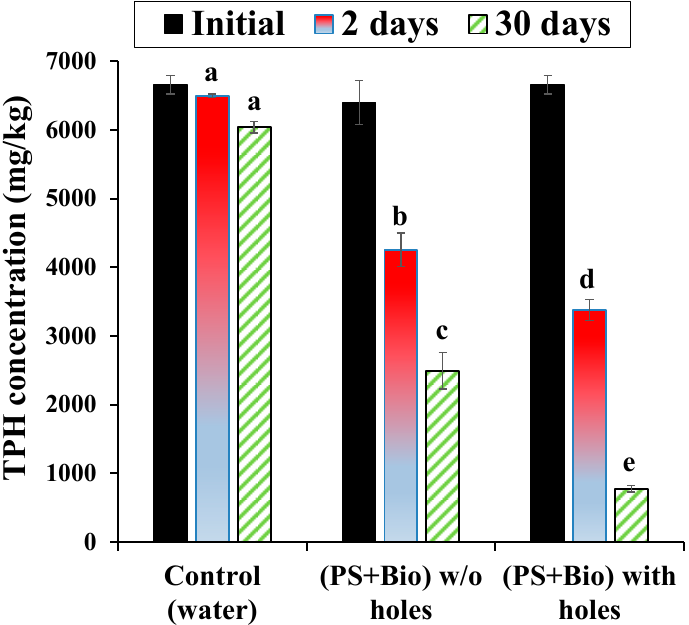
Figure 3. Effect of vertical soil holes on TPH removal by surfactant foam spraying. “Control (water)” indicates that water was poured onto the soil surface. “(PS + Bio) w/o holes” indicates persulfate (PS) oxidation (2 days) followed by bioaugmenation (Bio) (30 days) in the soil column without holes. “(PS + Bio) w/holes” indicates those with holes. The TPH was extracted from composite samples by mixing soils from three depths. The different letters ( a – e ) above the bars indicate significant differences ( p < 0.05, Tukey’s test).